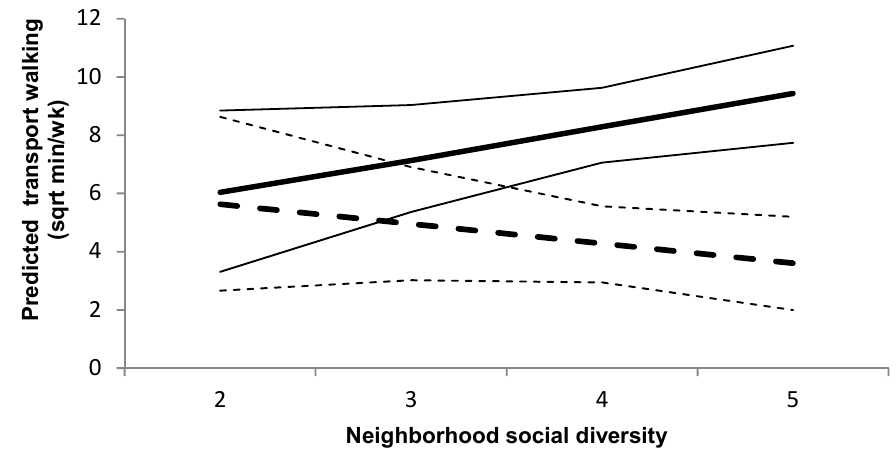
Figure 1. Interaction between the neighborhood social diversity and neighborhood walkability for the predicted transport walking. Plot represents transport walking (square root transformed variable) for high-walkability (thicker full line) and low-walkability (thicker dashed line) neighborhood residents, and their confidence intervals (thinner lines).